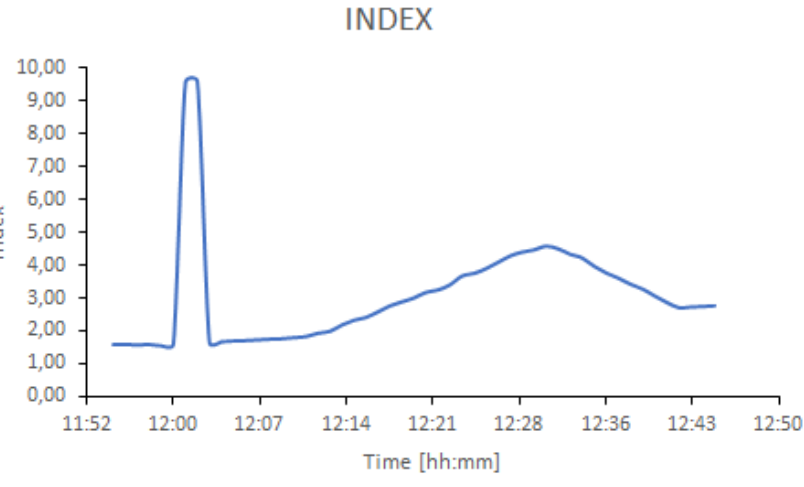
Figure 4. Calculated environment index